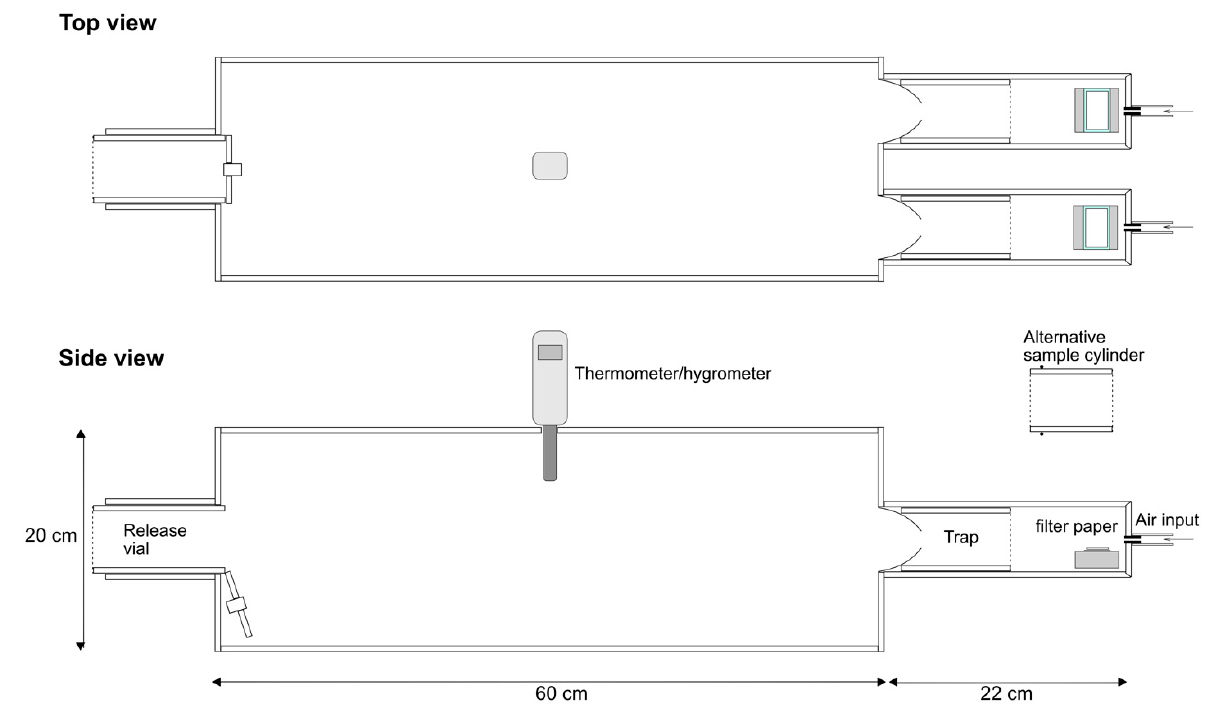
Figure 1. Schematic diagram of the dual-port olfactometer.